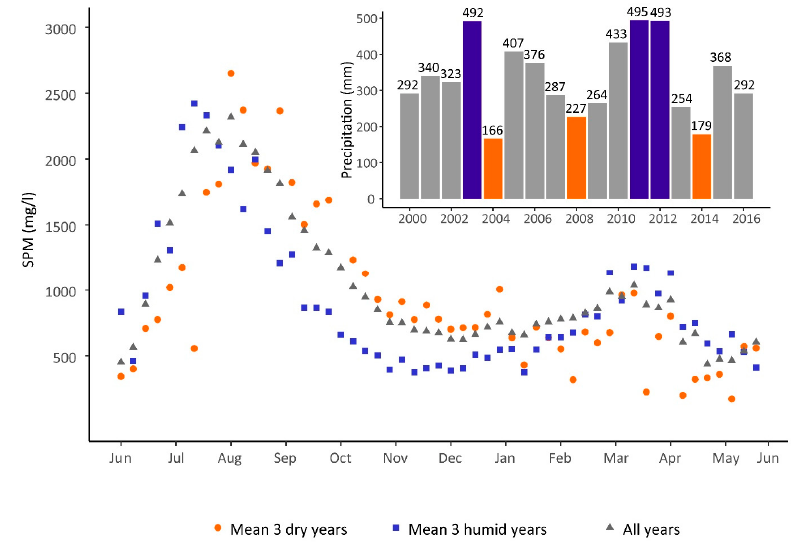
Figure 6. SPM seasonal cycle derived from MODIS for the Agoufou Lake: average for all years between 2000 and 2016 (gray), the three years with the lowest annual rainfall (orange), and the three years with the highest annual rainfall (blue). Annual rainfalls are shown in the inset.